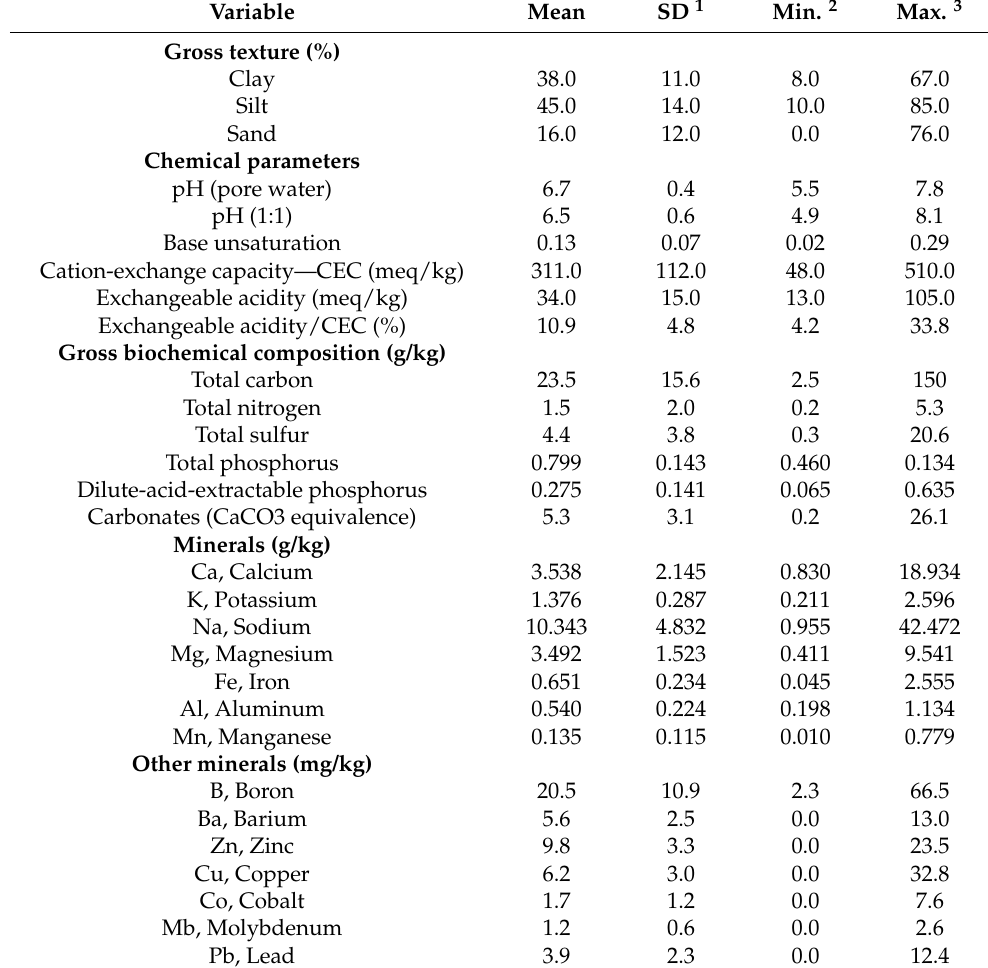
Table 1. Chemical properties of bottom soil of seawater ponds at Garho Fish Farm, Thatta, Pakistan.